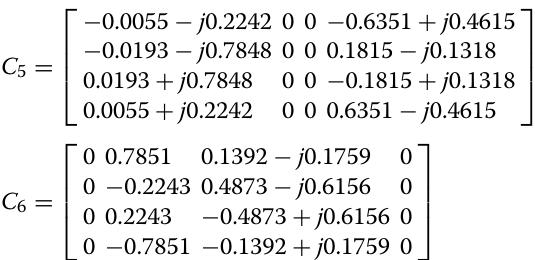
Table 3 brings some numerical examples of the LUT of the alphabet S 1 . The most part of the LUT is omitted for the sake of